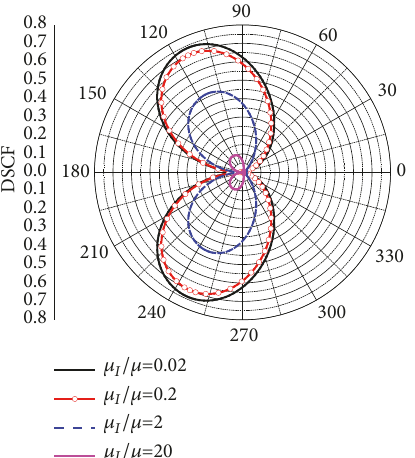
Figure 7: Effect of 𝜇 𝐼 /𝜇 on the DSCF with 𝐾 𝐼 /𝐾 = 𝜋 .